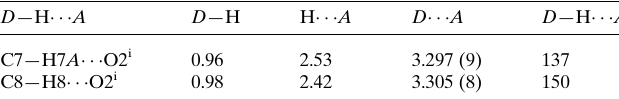
Table 1 Hydrogen-bond geometry (A˚ , (cid:2)